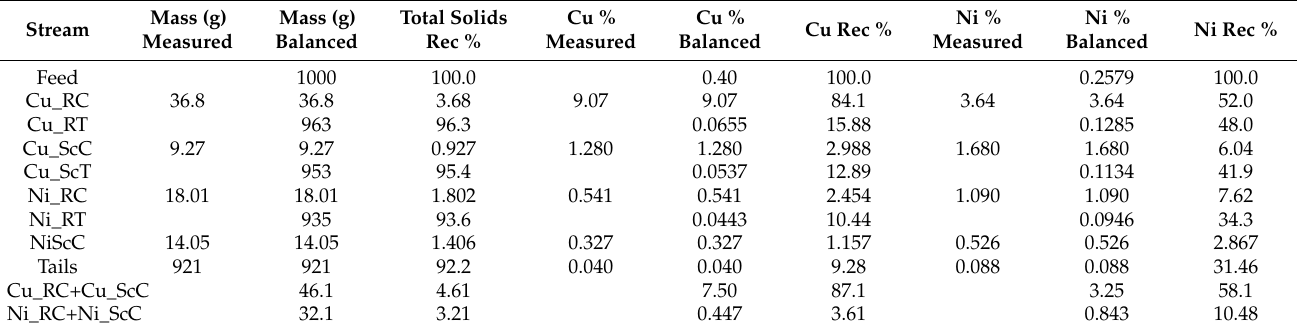
Table A1. Mass balance for flotation test Sep 08_01.